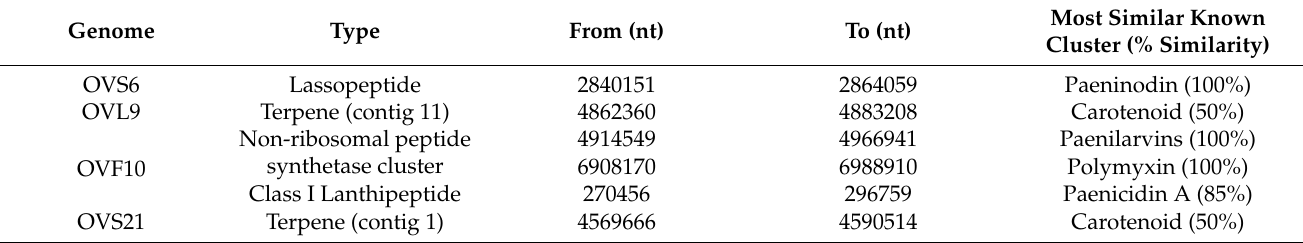
Table 4. Biosinthetic gene clusters identified using AntiSMASH and having the higher percentage of similarity. Nucleotide positions within the genome are